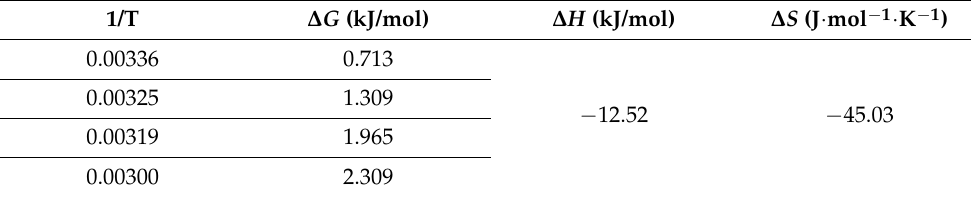
Figure 10. The Van’t Hoff plot of the adsorption of MB using SPGMA polymer. Table 3. Thermodynamic parameter valuesof the MB molecules adsorption on the SPGMA under different temperatures.